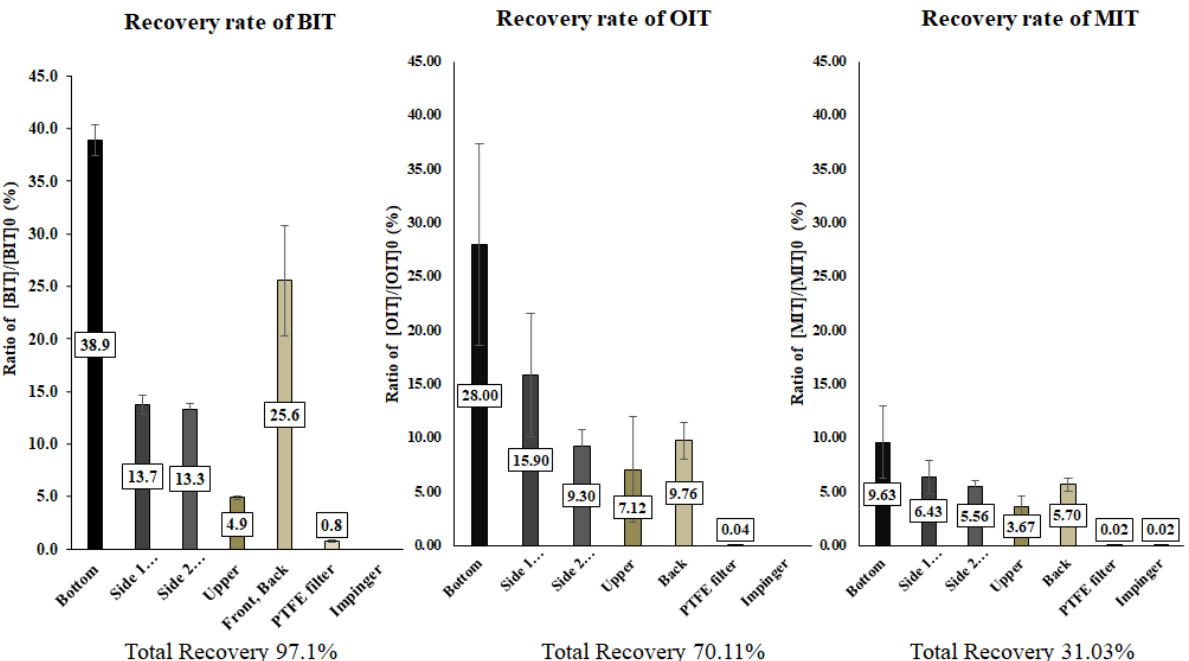
Figure 7. Disposition of biocide aerosols in the exposure chamber. The aerosolized isothiazolinones deposited on the chamber surface and escaped through the air flow (PTFE filter and an impinger) were collected and analyzed.